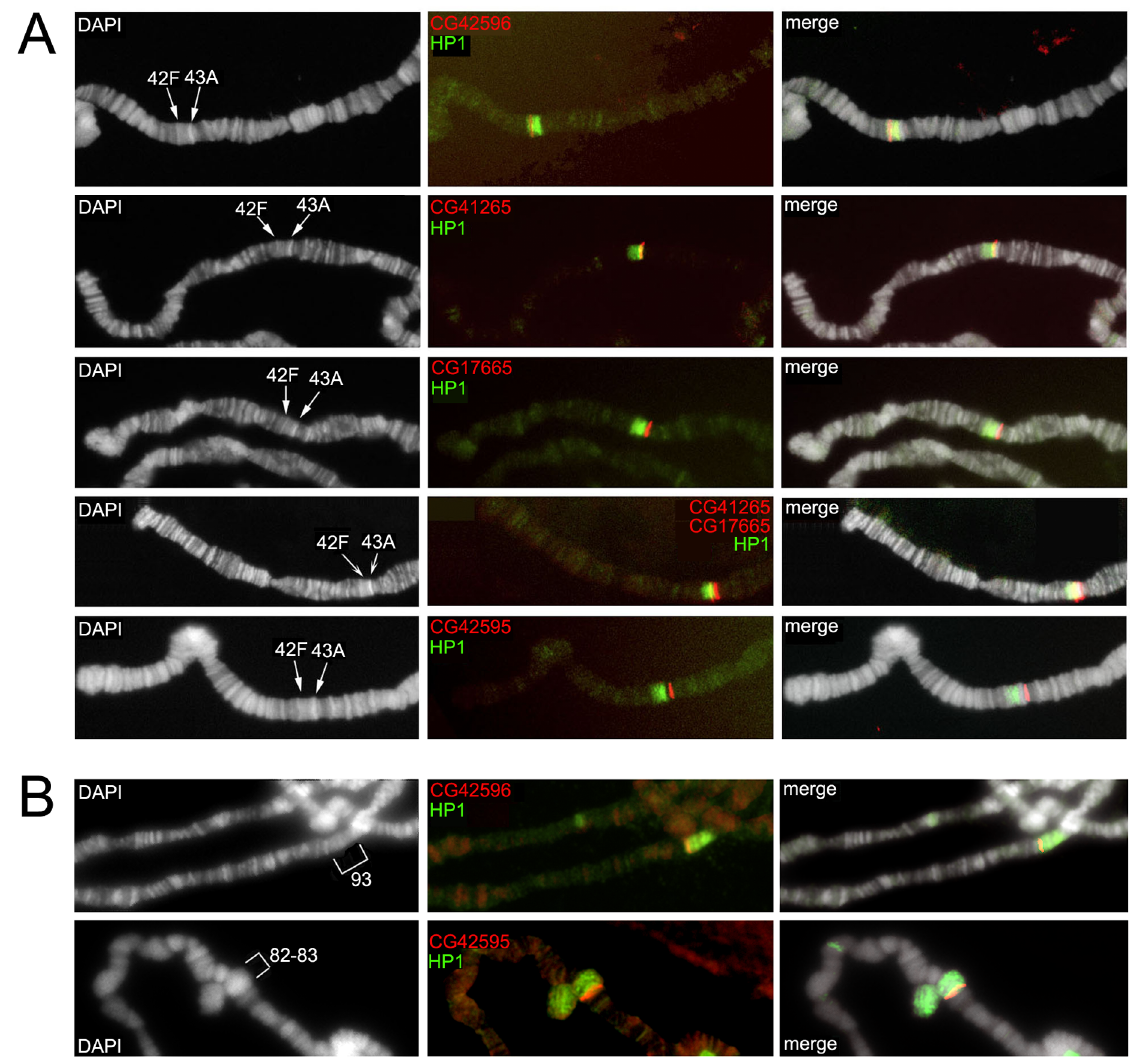
Fig 7. Sequential IF/FISH experiments performed on polytene chromosomes of D . virilis and D . pseudoobscura with anti- HP1a and specific gene probes. (A) In D . virilis , the FISH signals of CG41265 (GJ21982) and GJ21862 (CG42596), shown in red, map to the proximal and distal ends of region stained by anti-HP1a antibody (green). The FISH signals of CG42595 (GJ22088) and CG17665 (GJ17515) map to Dvir_43A. (B) In D . pseudoobscura the FISH signal of CG42595 ortholog is included in the large HP1 signal mapped to Dpse_83A; the FISH signal of CG42596 ortholog is included in the distal portion of the HP1 signal mapped to